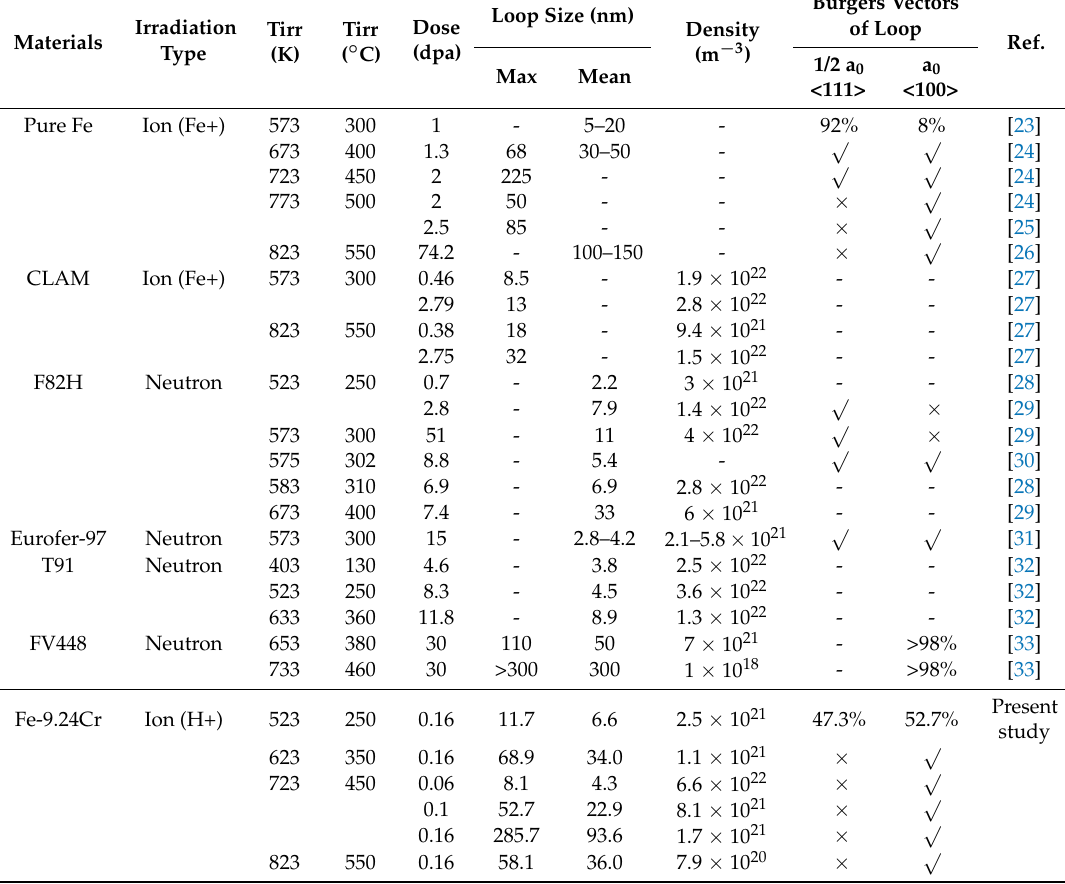
Table 2. Summary of dislocation loops in pure iron and iron-based alloys under the irradiations of Fe + and neutrons, as well as the present experimental